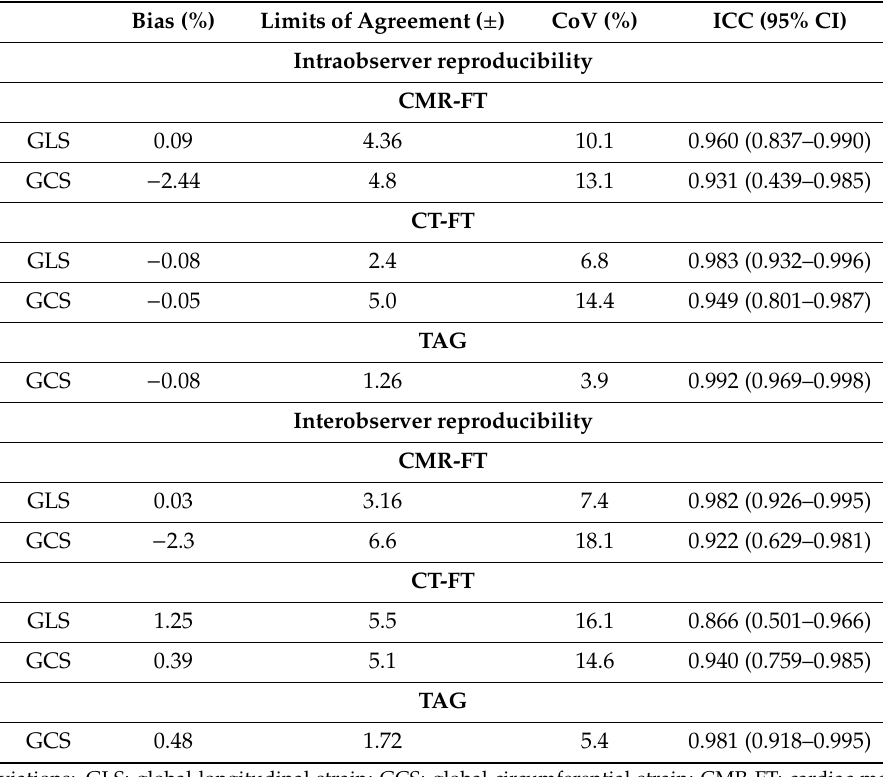
Table 5. Reproducibility comparison of GLS and GCS between CMR-FT, CT-FT, and